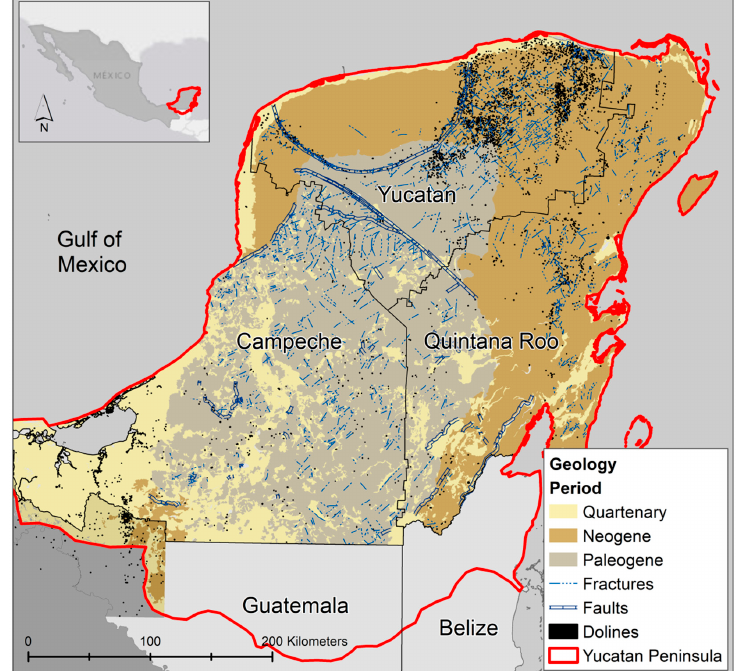
Figure 2. The Yucatan peninsula geology. Neogene carbonates present a high number of dolines in comparison with Paleogene areas due to more interaction between carbonates and sea level variations. Southern limits of the peninsula are displayed as those presented by Bauer-Gottwein [29], in accordance with Vinson [37] and López-Ramos [38]. In Yucatan, topography presents elevations above sea level varying from centimeters along the coast to approximately 30 meters inland with the exception of a hill area located at the southern part of Yucatan where elevation is up to 205 meters [39]. The flat topography of the region and considerable karstification allow infiltration to act at fast rates without runoff generation [40]; this makes groundwater the only source for water supply in Yucatan [41]. Data from the National Meteorological Service shows a mean annual precipitation of about 1100 mm/year in a seasonal pattern, with intensities varying from 10 to 20 mm/day [42]. Precipitation also varies spatially; the coastal area in the northwest receives an average of 550 mm/year and is thus relatively dry, whilst the Yucatan south eastern region receives up to 1500